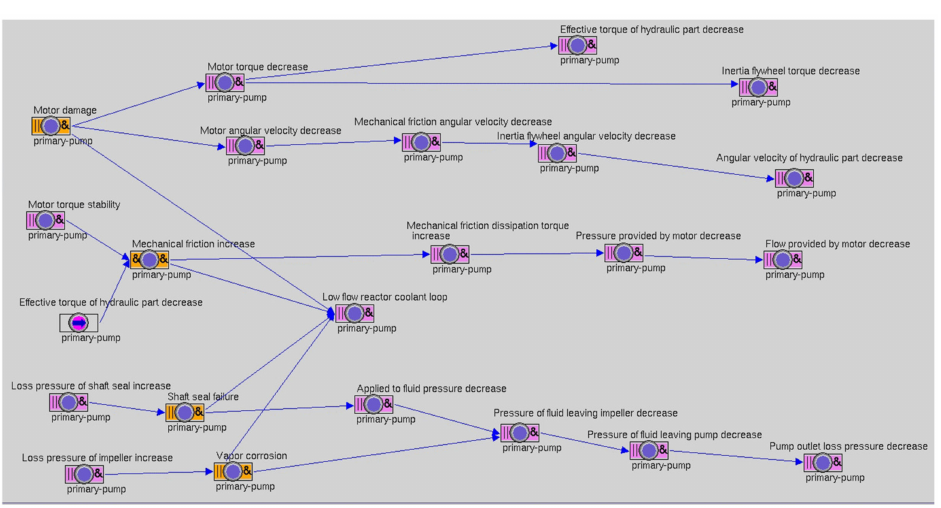
Figure 25. Design of inference engine for the reactor coolant